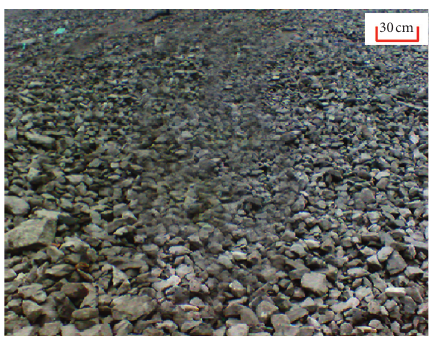
Figure 1: Raw coal gangue.